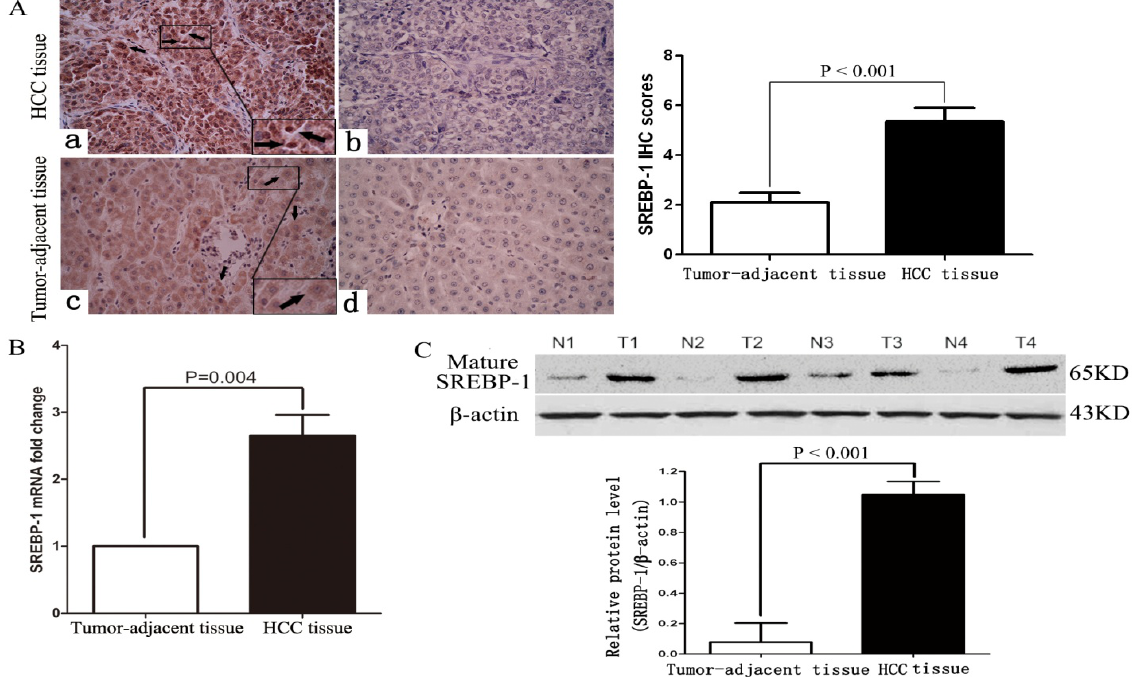
Figure 1. SREBP-1 expression in HCC cases. ( A ) Immunostaining of SREBP-1 in HCC and tumor-adjacent tissues: ( a ) positive expression of SREBP-1 in HCC tissue (labeled by black arrows); ( b ) negative expression of SREBP-1 in HCC tissues; ( c ) positive expression of SREBP-1 in tumor-adjacent tissues (labeled by black arrows); ( d ) negative expression of SREBP-1 in tumor-adjacent tissues (original magnification ×400). n = 47. Values